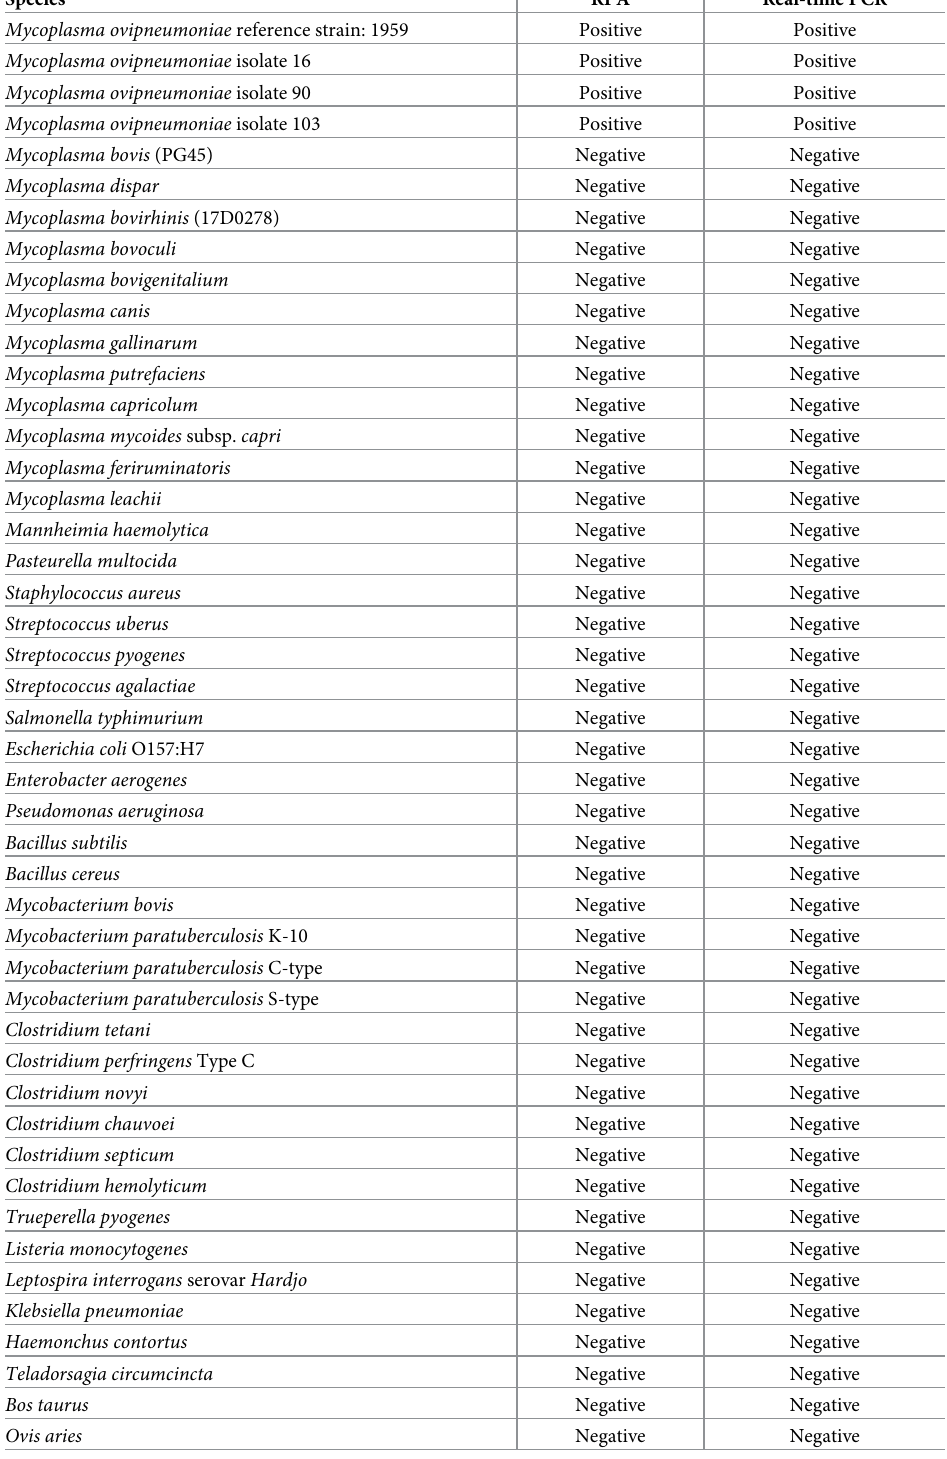
Table 2. Specificity of M . ovipneumoniae RPA-LFD assay against other